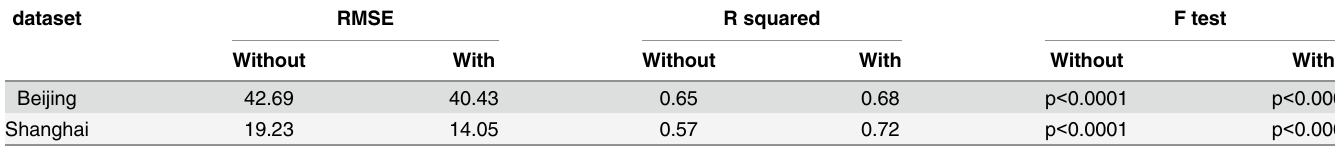
Table 3. Regression results with and without humidity as a feature. dataset